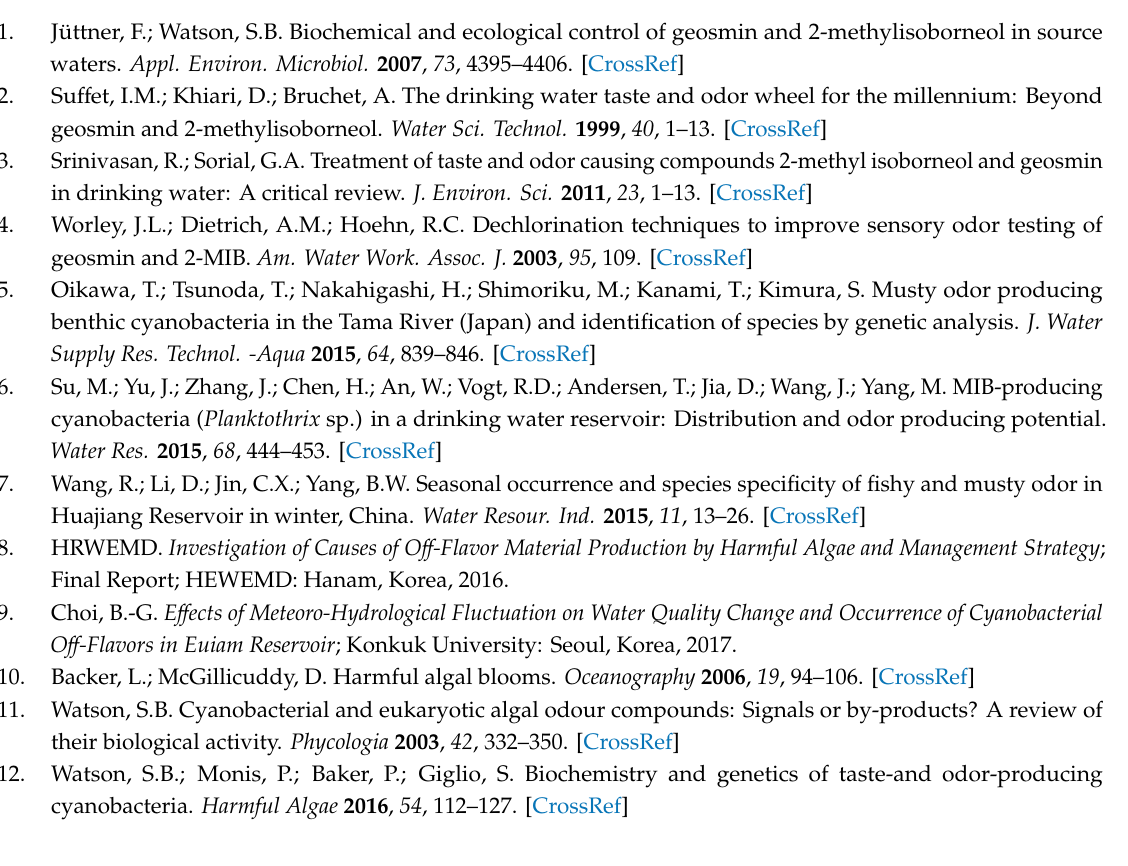
Figure S1: location of the sampling site (red circle) in the estuary region of the Gong-ji stream, Figure S2: nonspecific band occurrence for all tested strains according to annealing temperature, Figure S3: detection of mibC genes from the field samples by PCR, Figure S4: phylogenic analysis of 2-MIB-synthesizing gene (mibC) sequences obtained using the designed primers with sequences from the GenBank database, Figure S5: seasonal variation in mibC copy number (a), gene expression (b) in the water column and sediment, 2-MIB concentration (c), and Pseudanabaena limnetica cell density (d) in the water column of the Gong-ji Stream between February 2015 and February